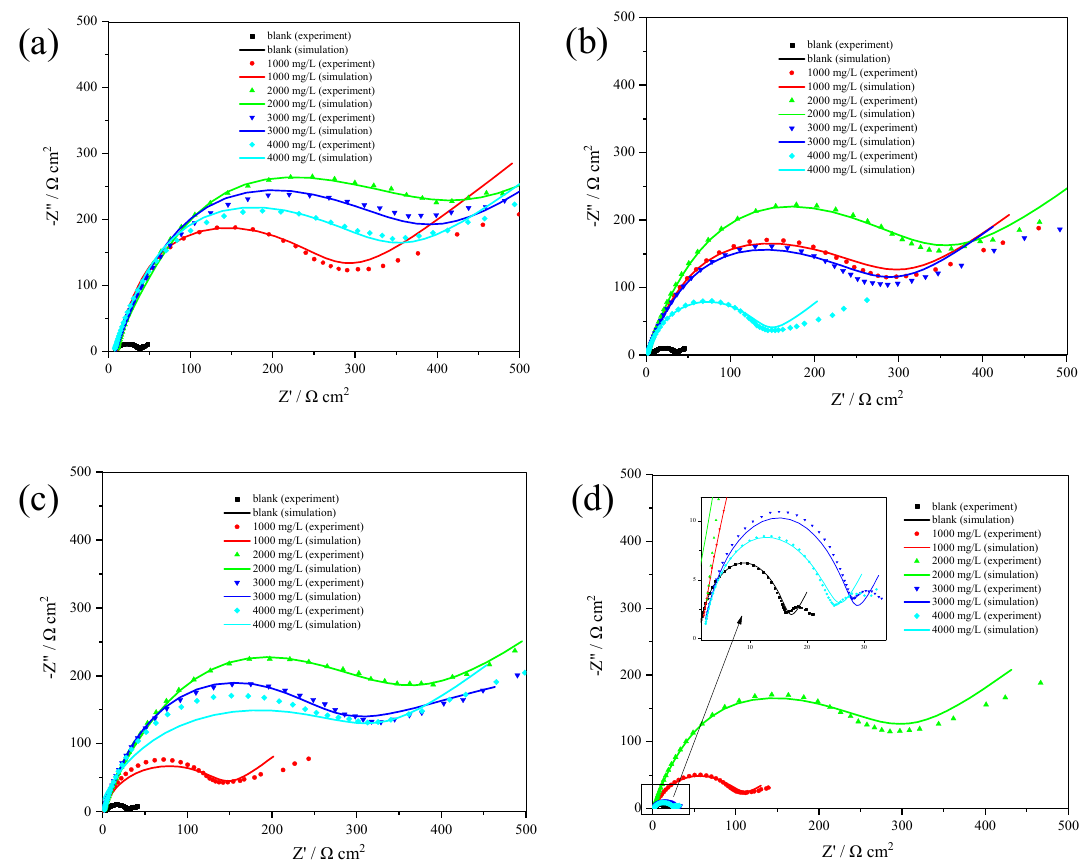
Figure 5. Nyquist plots for 304 SS with and without inhibitor in 0.5 M ( a ), 1.0 M ( b ), 1.5 M ( c ), and 2.0 M H 2 SO 4 solution ( d ).